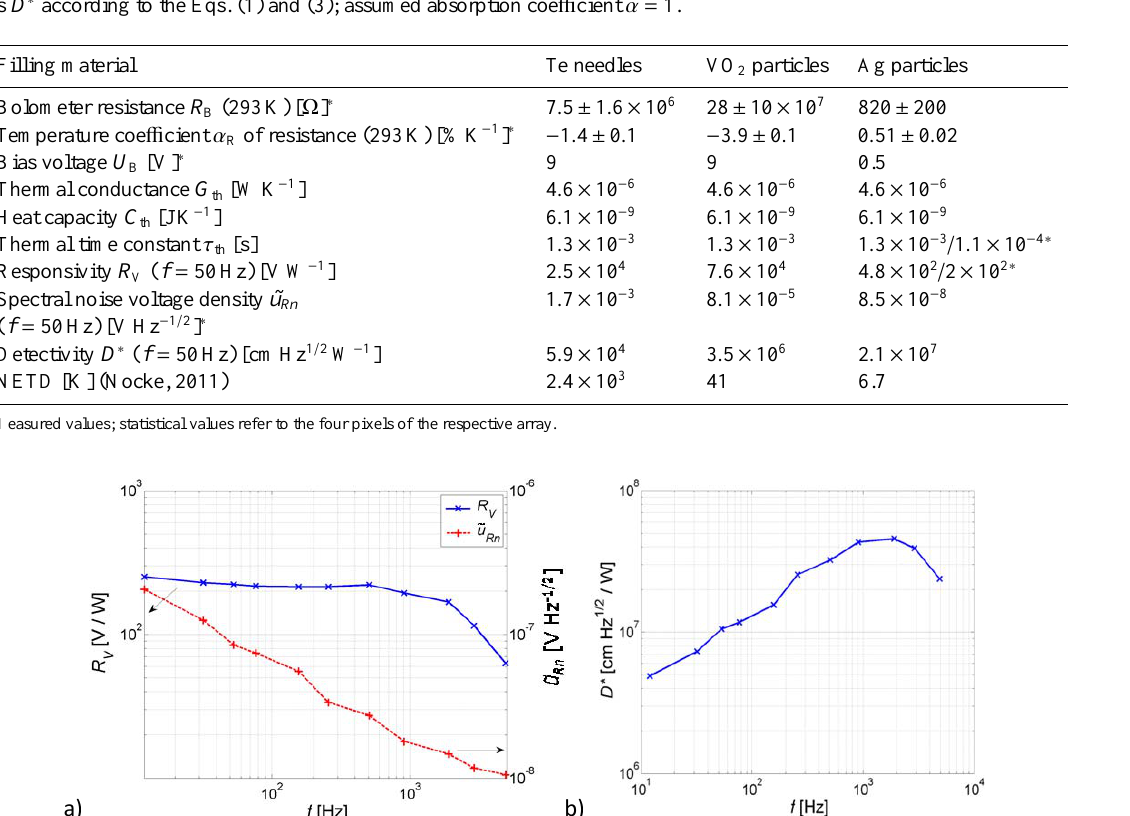
and spectral noise voltage density ũ V